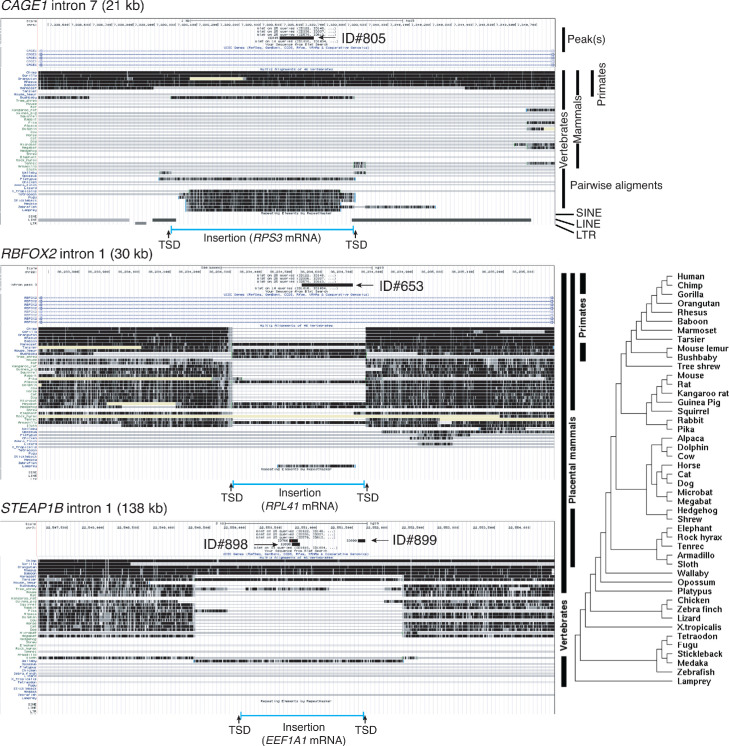
Genome browser (UCSC) screenshots showing additional examples of long introns containing retrotransposed mRNAs sequences that are called as peaks.The host gene, intron number, and intron length are indicated at the top, with the called peak or peaks (thick black line(s)) and peak ID indicated in the top track. The customized tracks below show alignments of genomic sequences of different organisms (phylogenetic tree shown to the right), and locations of nearby SINE and LINE elements shown below. The inserted retrotransposed mRNA sequence (bracketed blue line at the bottom) is identified by gap in genomic sequence for organisms that do not contain the insertion and by target site duplications (TSDs; 5–20 nt direct repeats) flanking the inserted sequence.